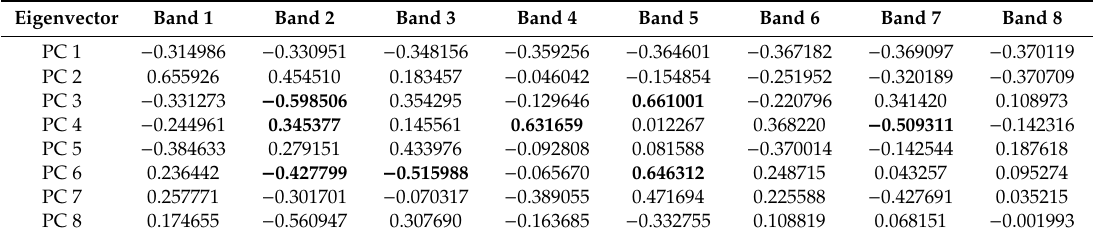
Table 5. Eigenvector matrix derived from PCA for the selected bands of WV3 band (1 to 8 VNIR) used in this